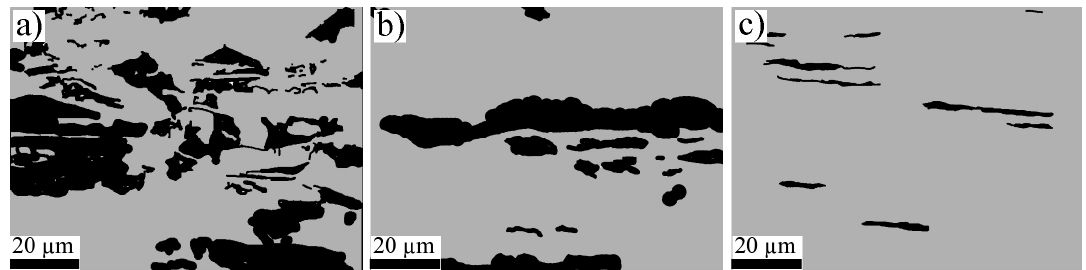
Figure 4. DA grains, colored in black, for the analysis of their fraction (see Figure 2b,d,f) in ( a ) 750- 0.1-32CR, ( b ) 750-0.1-45CR and ( c ) 750-0.1-63CR.